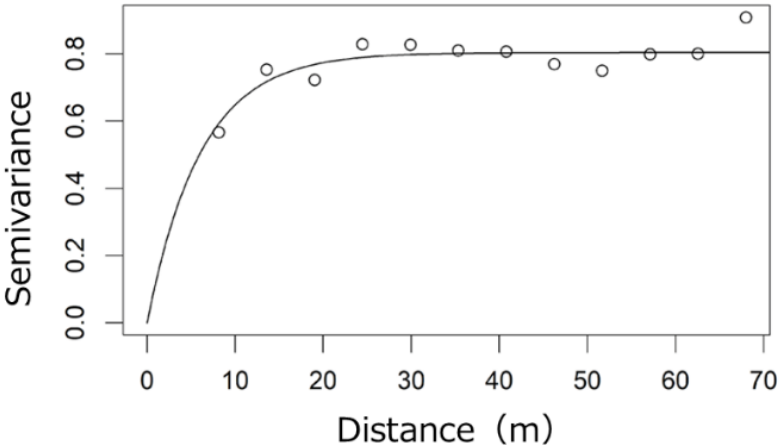
Figure 4. Semivariogram of LAI. The horizontal axis is the distance between the measurement points, and the vertical axis is the semivariance. A high semivariance indicates a weak correlation between data points collected at that distance.